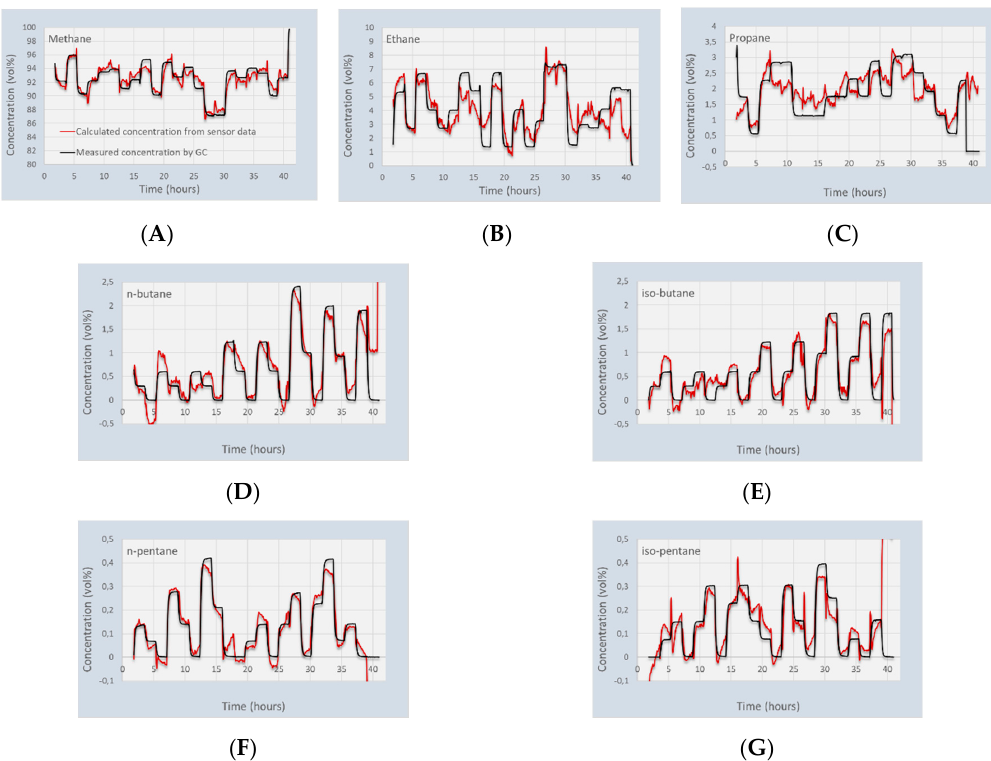
Figure 5. Recalculated gas concentrations in the 22 gas mixtures, compared to the values from the GC. ( A ) Methane; ( B ) Ethane; ( C ) Propane; ( D ) n-butane; ( E ) iso-butane; ( F ) n-pentane; ( G ) iso-pentane.